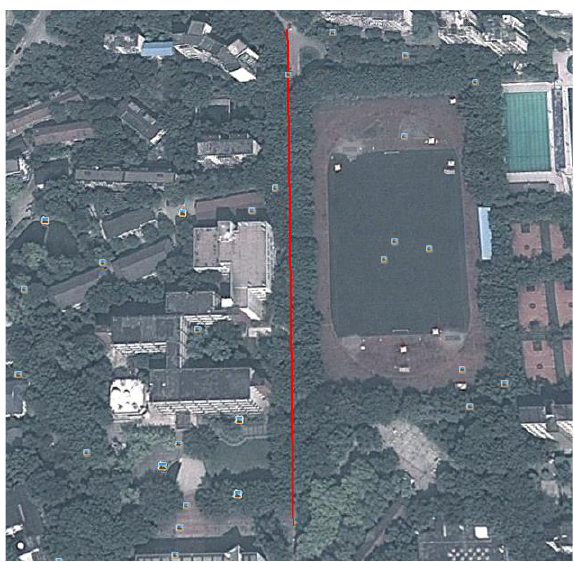
Figure 12. Thick foliage environment.